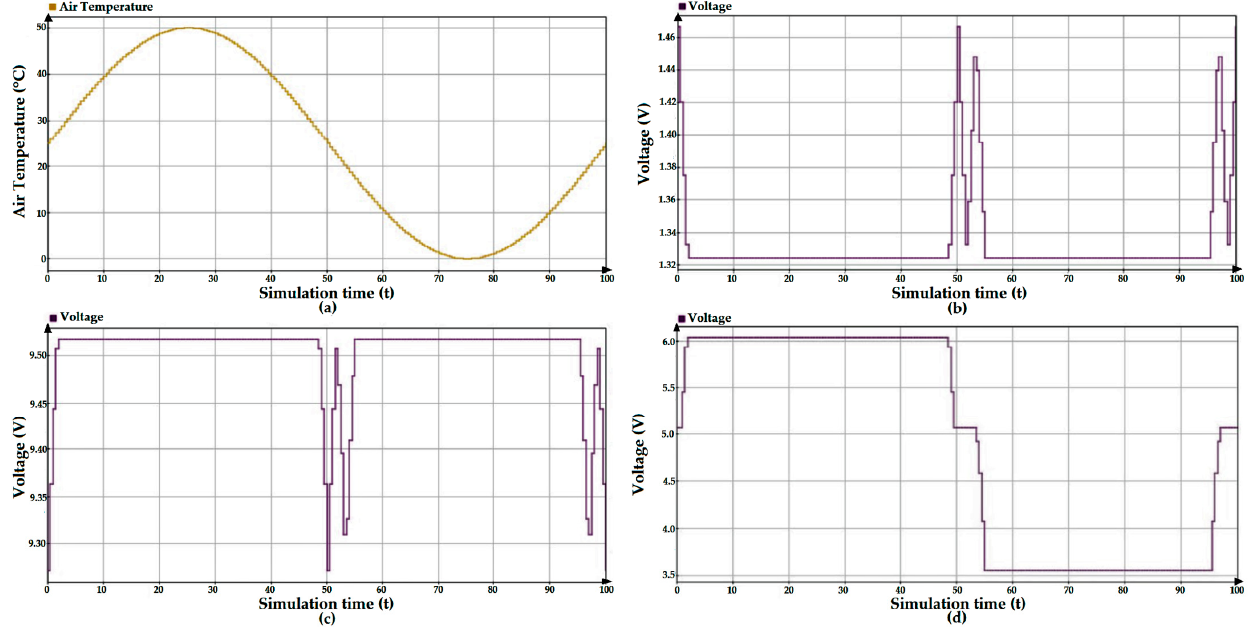
12 of 20 Figure 13. ( a ) Solar irradiance vs time; ( b ) voltage vs time at minimum water need; ( c ) voltage vs time at maximum water need; ( d ) voltage vs time at standard operating conditions. Similarly, considering that the need for water is at maximum w.r.t. to the other var- iables, the effect of solar irradiance on the pump voltage is defined by the graph shown in Figure 13c, Considering solar irradiance value from Figure 13a. We can see that the range of the pump voltage has shifted from 1.35–3.4 V to 7.25–9.5 V, and it is still in accordance with our Equation (5), as the voltage is increased when solar irradiance increases from 300.00–500.00 W/m² and vice versa. The range of the pump voltage is changed slightly from 7.25–9.5 V to 3.5–6.25 V at standard operating conditions, according to Figure 13d, Considering the solar irradiance value from Figure 13a. To get the graph at standard operating conditions, we manually set soil moisture to 50%, air temperature to 25 °C, and air humidity to 50%. This slight decrease in the range is due to a decrease in solar irra- diance value from 1000.00 W/m² at max to 600.00 W/m², while the graph is almost iden- tical. 4.1.3. Air Temperature According to Equation (6), the effect of air temperature on the pump voltage should